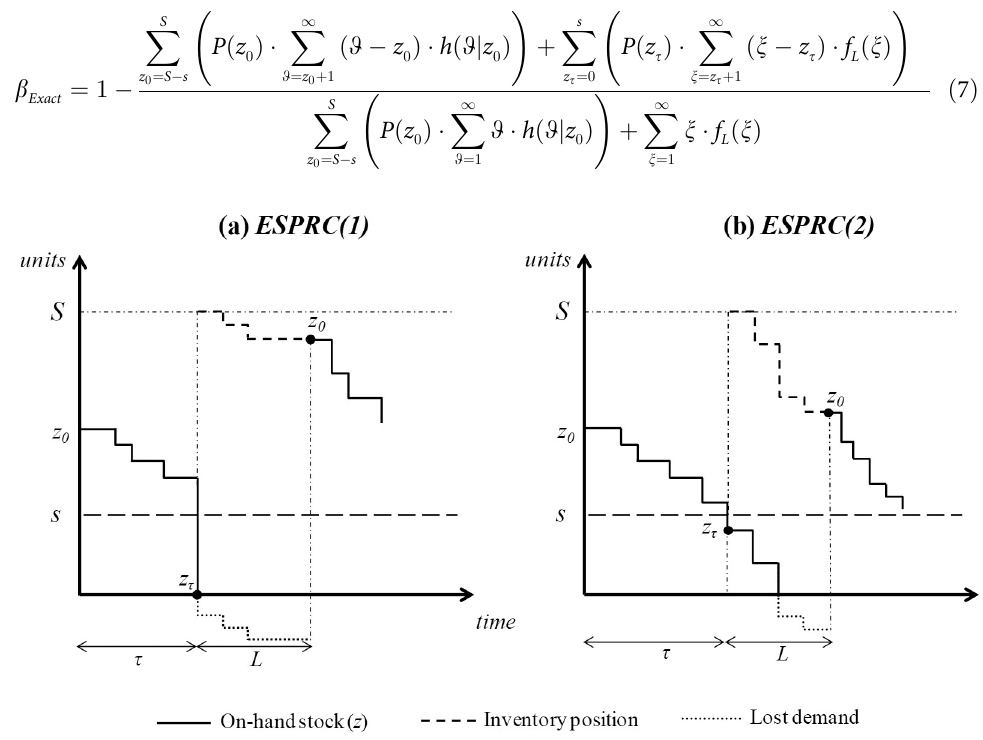
Fig 3. Evolution of a ( s , S ) inventory policy that illustrates the ESPRC(1) and ESPRC (2) cases.